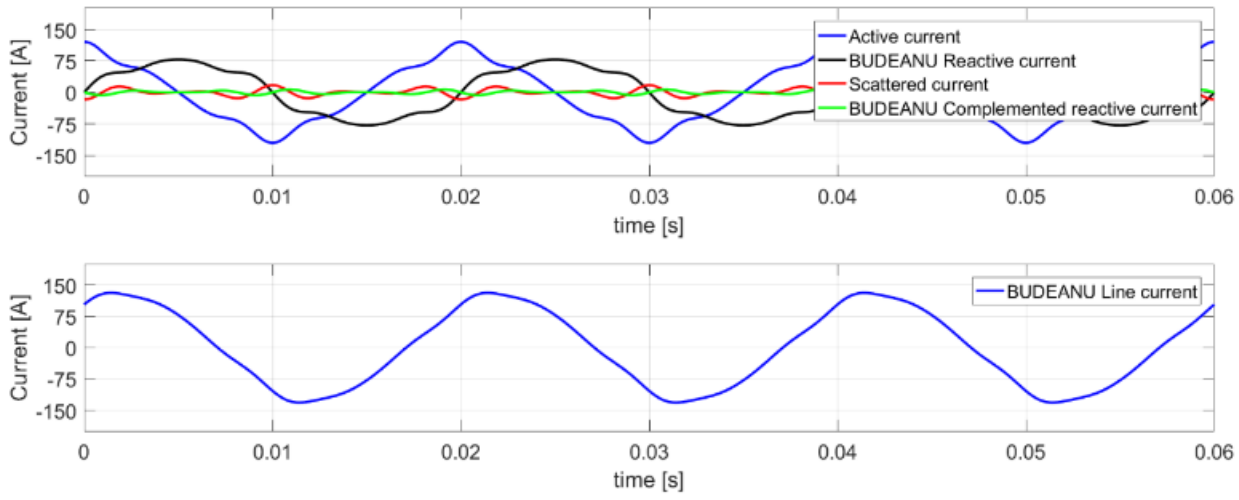
Figure 6. The waveform of the currents’ components and current of the load in developed Budeanu’s theory.